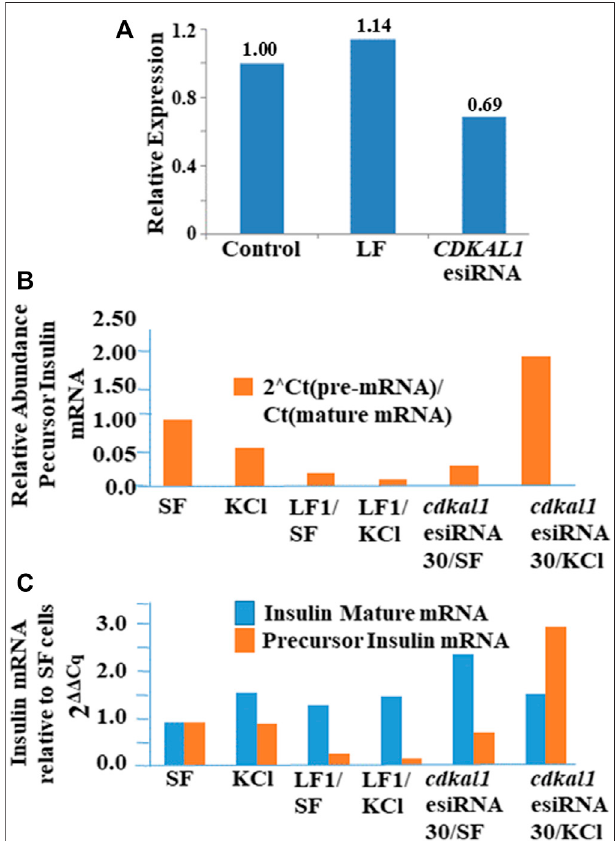
FIGURE 4 | Insulin, precursor insulin and Cdkal1 mRNA levels in cdkal1 esiRNA knockdown cells. (A) Relative expression of insulin mature mRNA relativetopre-mRNAisincreasedwithstimulationinnormalNIT-1cells. (B) Mature insulin mRNA is signi fi cantly reduced in KCl stimulated knockdown cells. mRNA levels were normalized to actin mRNA and expressed as fold-change to Control normal NIT-1 cells. LF cells — transfected with Lipofectamine only, esiRNA30 — transfected with esiRNA 30 nM. In cdkal1 -esiRNA treated knockdown cells, the mRNA levels were reduced by ∼ 30%. Threshold Cq